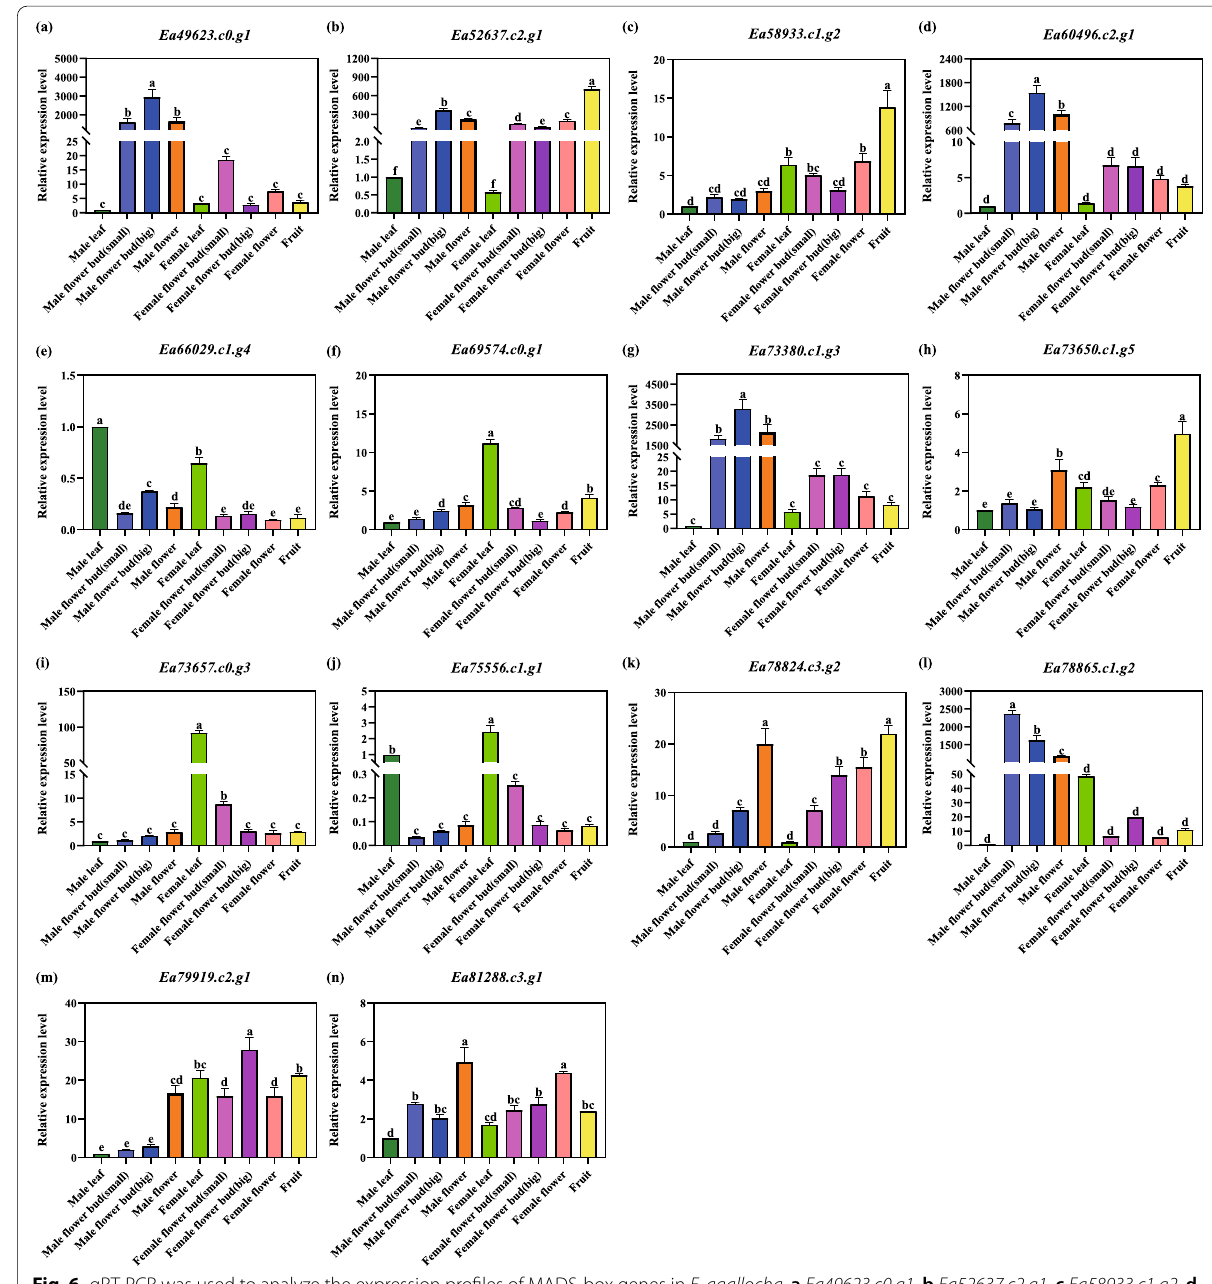
Fig. 6 qRT-PCR was used to analyze the expression profiles of MADS-box genes in E. agallocha . a Ea49623.c0.g1 . b Ea52637.c2.g1 . c Ea58933.c1.g2 . d Ea60496.c2.g1 . e Ea66029.c1.g4 . f Ea69574.c0.g1 . g Ea73380.c1.g3 . h Ea73650.c1.g5 . i Ea73657.c0.g3 . j Ea75556.c1.g1 . k Ea78824.c3.g2 . l Ea78865.c1.g2 . m Ea79919.c2.g1 . n Ea81288.c3.g1 . Note: The actin gene as the internal control for gene expression